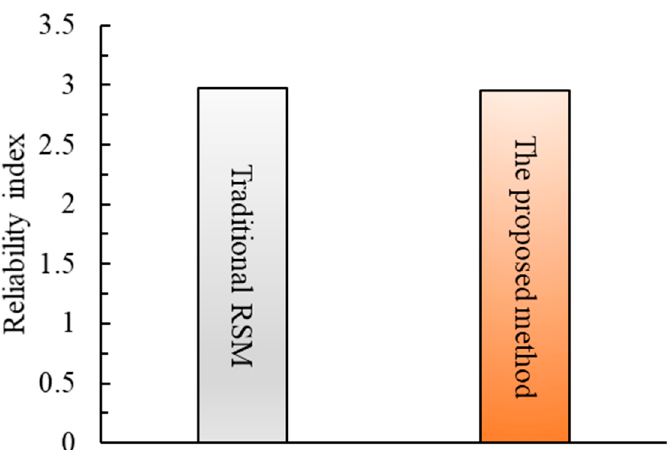
Figure 13. The comparison of reliability index using different method.